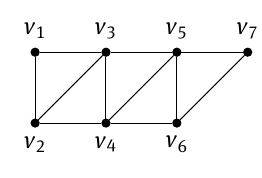
Figure 1: A strut on seven